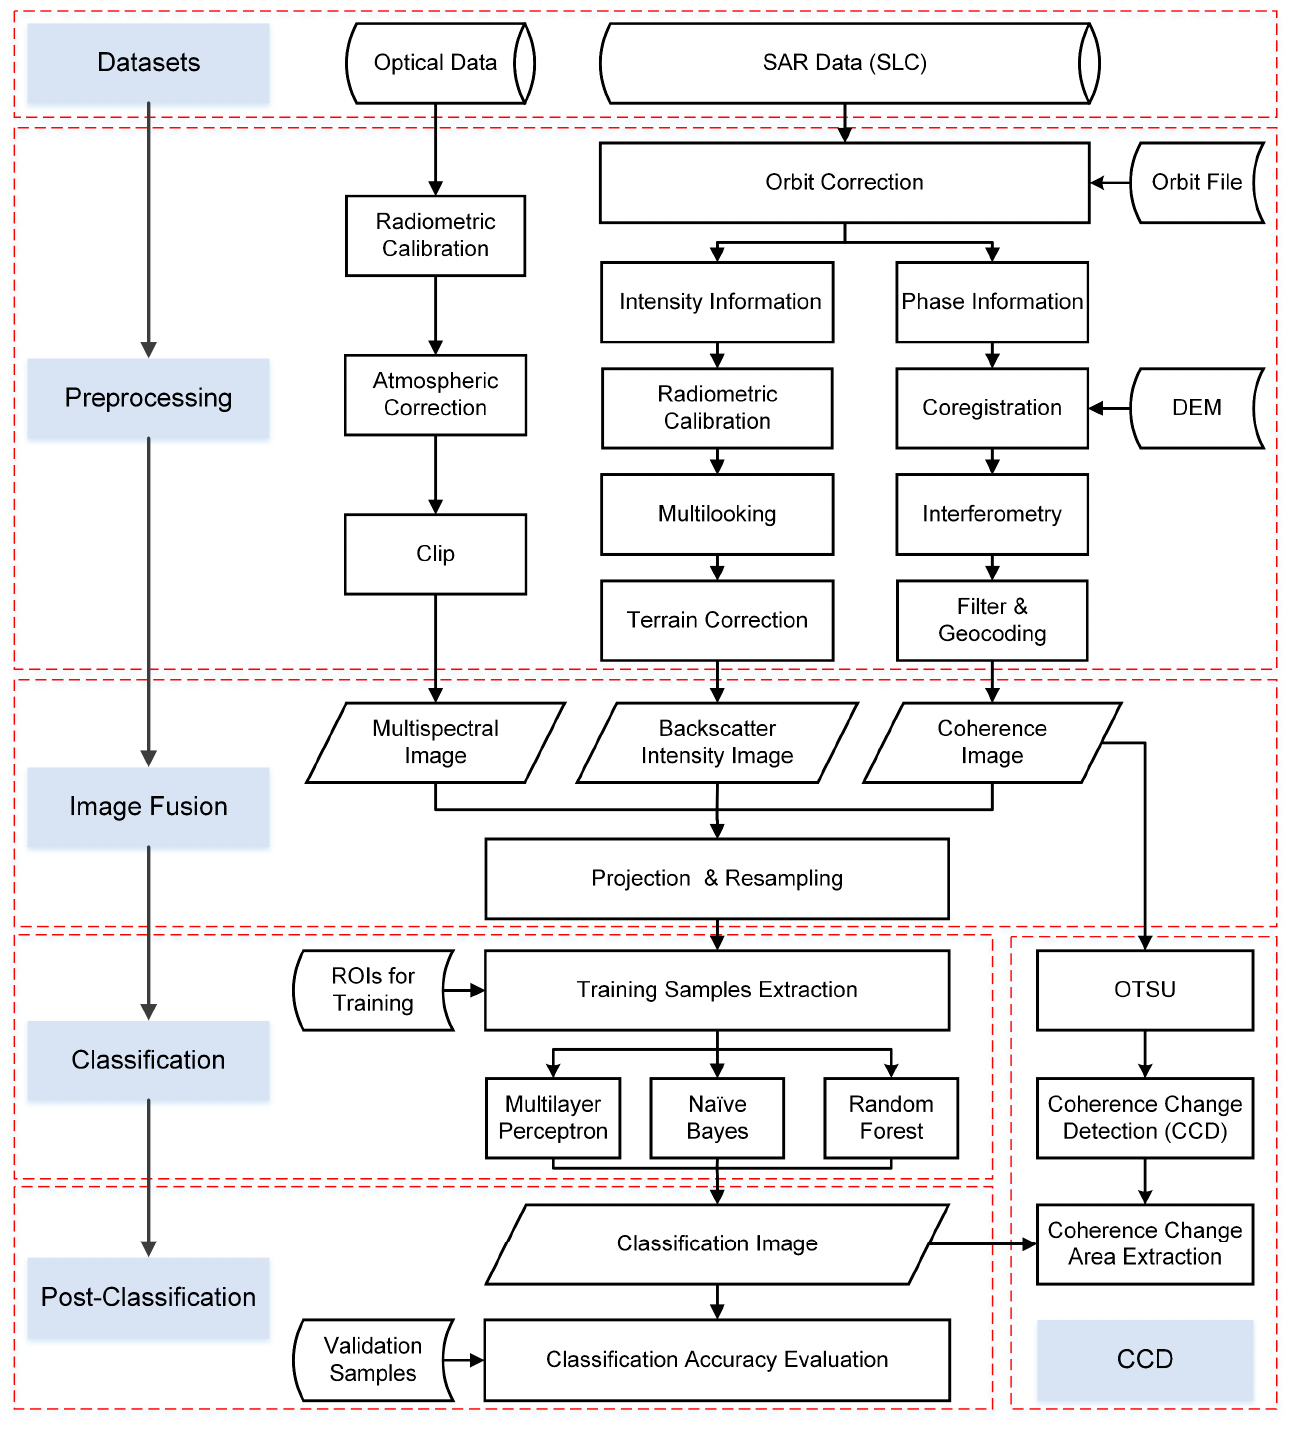
Figure 3. Workflow of data preprocessing, image fusion, coherence change detection, classification, and post-classification. and